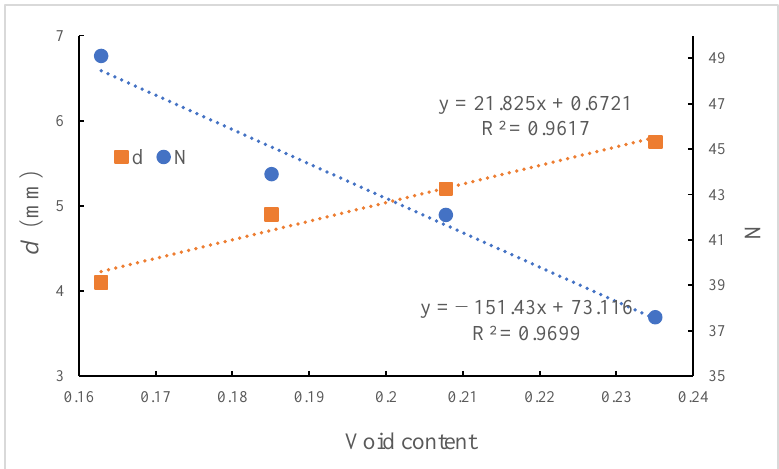
Figure 5. Relationship between 𝑑 , 𝑁 and the void content.